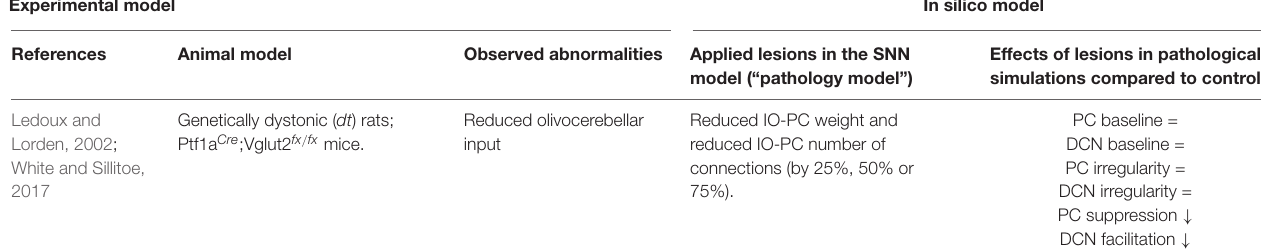
TABLE 1 | Summary table of experimental models of dystonia and corresponding in silico models. Experimental model In silico